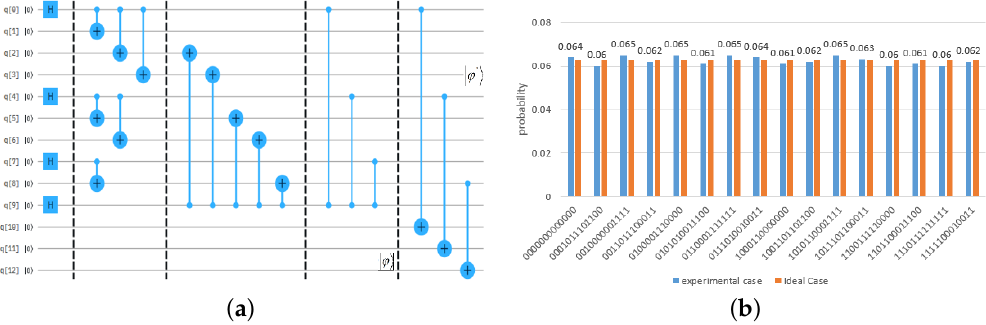
Figure 2. The construction of the target channel. ( a ) Quantum circuit illustrating the construction of target channel. ( b ) The histogram shows theoretical and experimental results of the quantum state’s mean probability distribution. The x-axis of this histogram is arranged in the order of ( c (cid:48)(cid:48)(cid:48) , b (cid:48)(cid:48) , · · · 2,1 ) from the bottom to the top, showing the average probability and percentage error of each state in the target channel of 13 qubits.